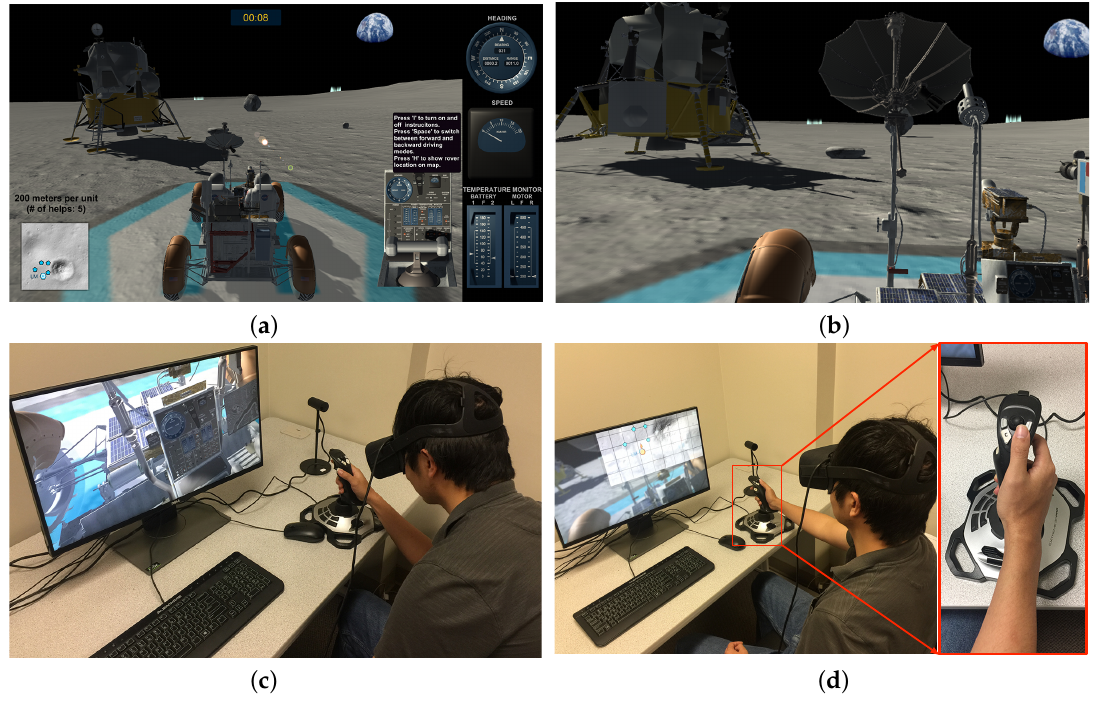
Figure 3. Screenshots and control examples of the driving phase. ( a ) is the 3D environment for the non-VR version of the game, with the navigation system on the right side of the screen, ( b ) is the 3D environment of the first-person view for the VR version of the game, ( c ) shows the head movement with the head-mounted display (HMD) for the readings of the navigation devices in the control console, and ( d ) shows the operation with the flight stick to bring up the mini map in the VR version of the